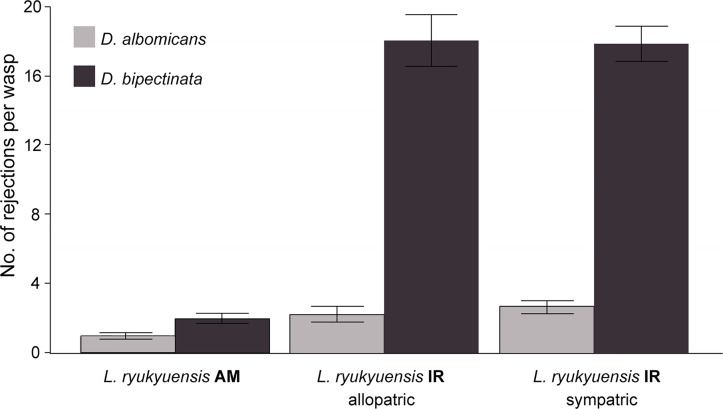
Number of rejections per wasp during an oviposition sequence.Rejection of NH flies by AM wasps, NH flies by IR wasps, and IR flies by IR wasps. Oviposition sequence is measured as 20 successful subsequent oviposition events. Average and standard error are shown.